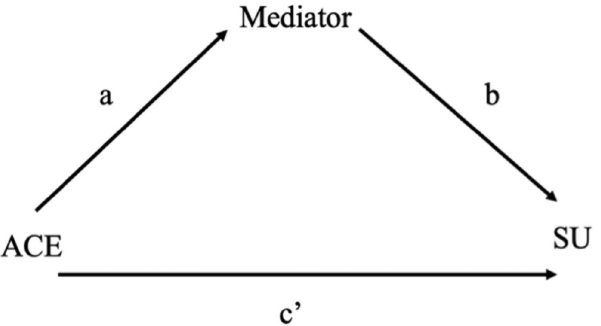
Fig 1. Mediation paths. Representation of direct and indirect effects examined in mediation analysis. The effect of the predictor (ACE) on the mediator corresponds to path a; the effect of the mediator on the substance use outcome corresponds to path b. The indirect effect is the effect of the ACE on the substance use outcome via the mediator, and is the product of paths a and b (ab). The direct effect corresponds to c’ and represents the effect of the ACE on the substance use outcome that does not occur via the mediator. The total effect of the ACE on the substance use outcome is the sum of the indirect (ab) and direct (c’) effects.